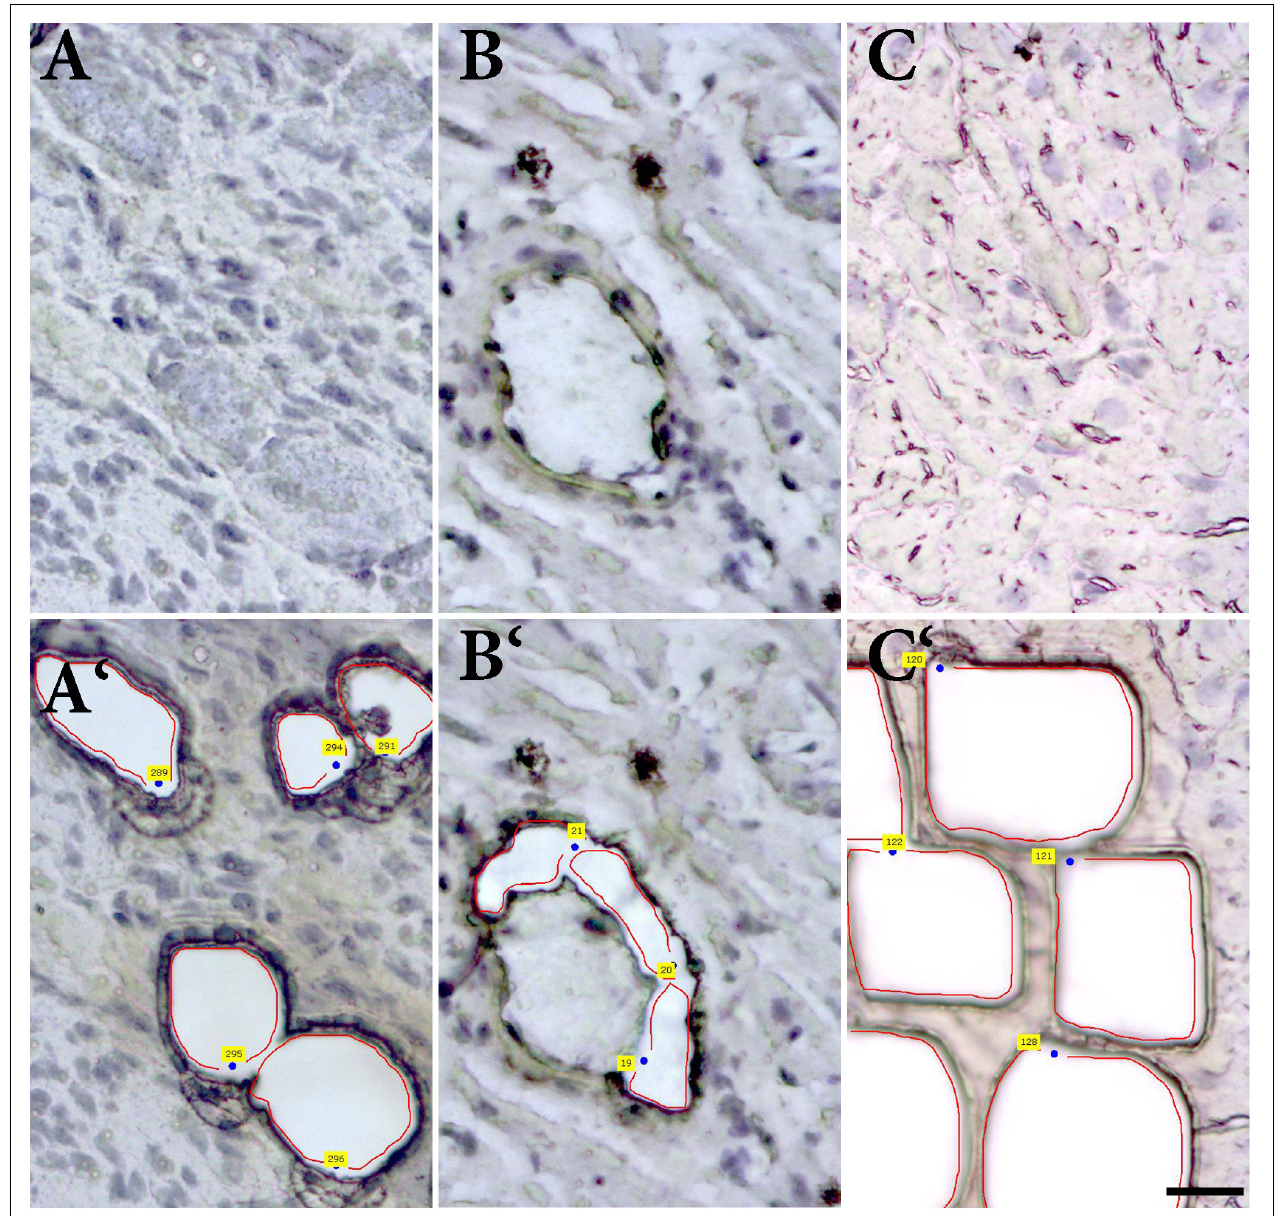
FIGURE 6 | Laser-assisted microdissection. Tissue sections before and after the dissection of (A,A‘) ganglion cells, (B,B‘) smooth muscle cells of coronary artery, and (C,C‘) and